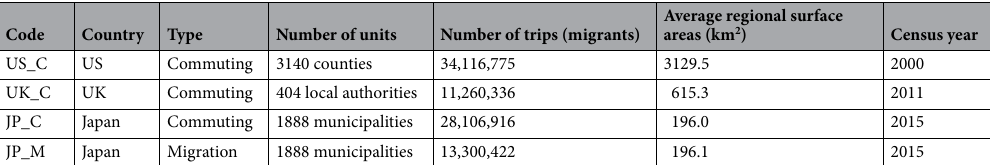
Table 1. Description of the datasets used to the newly modified radiation model and compare it other